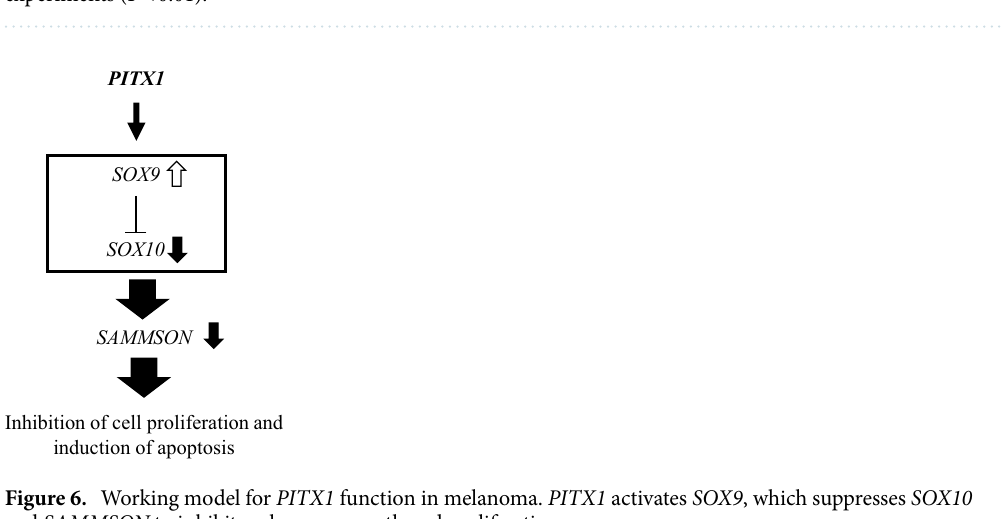
Figure 6. Working model for PITX1 function in melanoma. PITX1 activates SOX9 , which suppresses SOX10 and SAMMSON to inhibit melanoma growth and